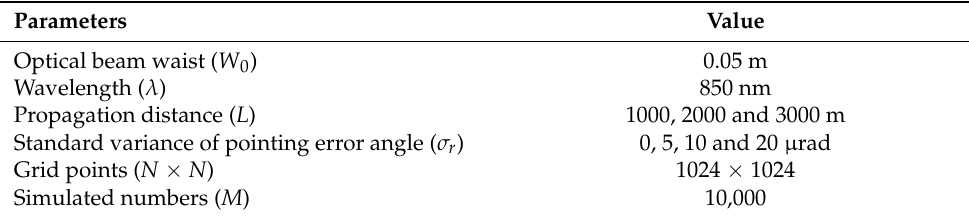
Table 2. Simulation parameter settings.